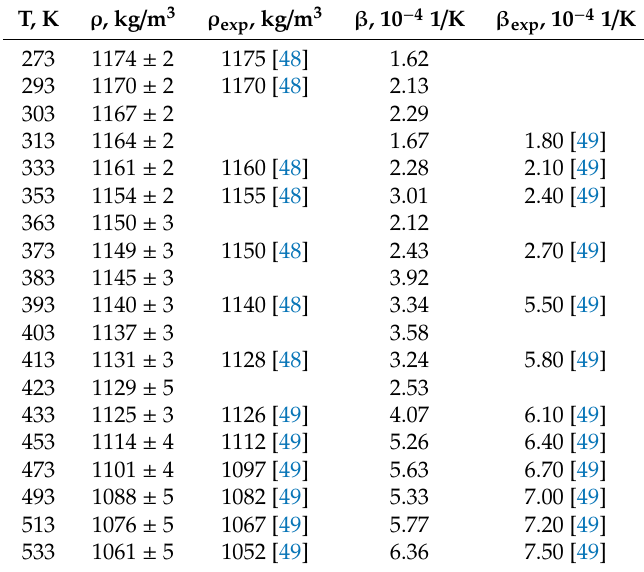
Table 3. Comparison of properties (density ρ and coe ffi cient of thermal expansion β ) at atmospheric pressure in the temperature range 273 – 533 K obtained by using MD and experimentally. T, K ρ , kg / m 3 ρ exp , kg / m